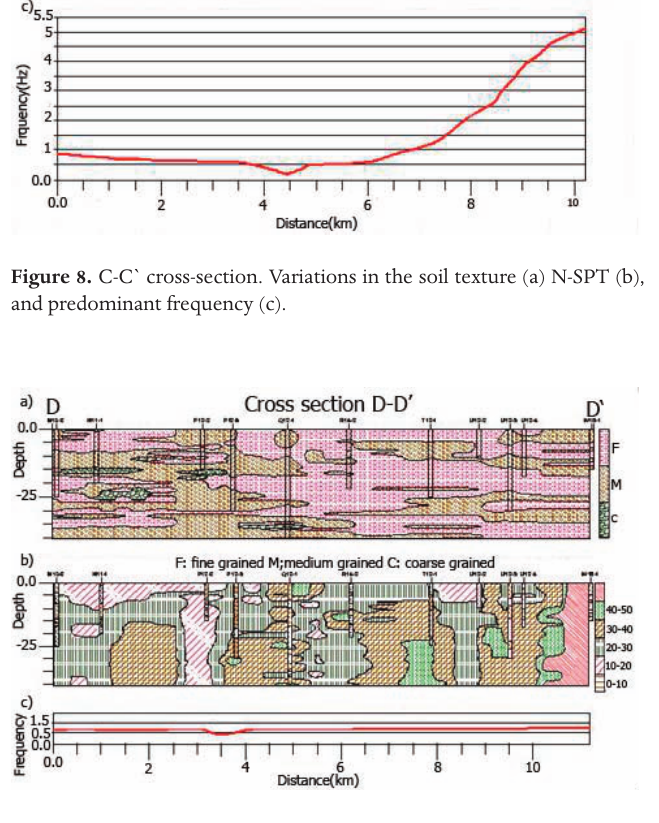
Figure 9. D-D` cross-section. Variations in the soil texture (a), N-SPT (b), and predominant frequency (c).